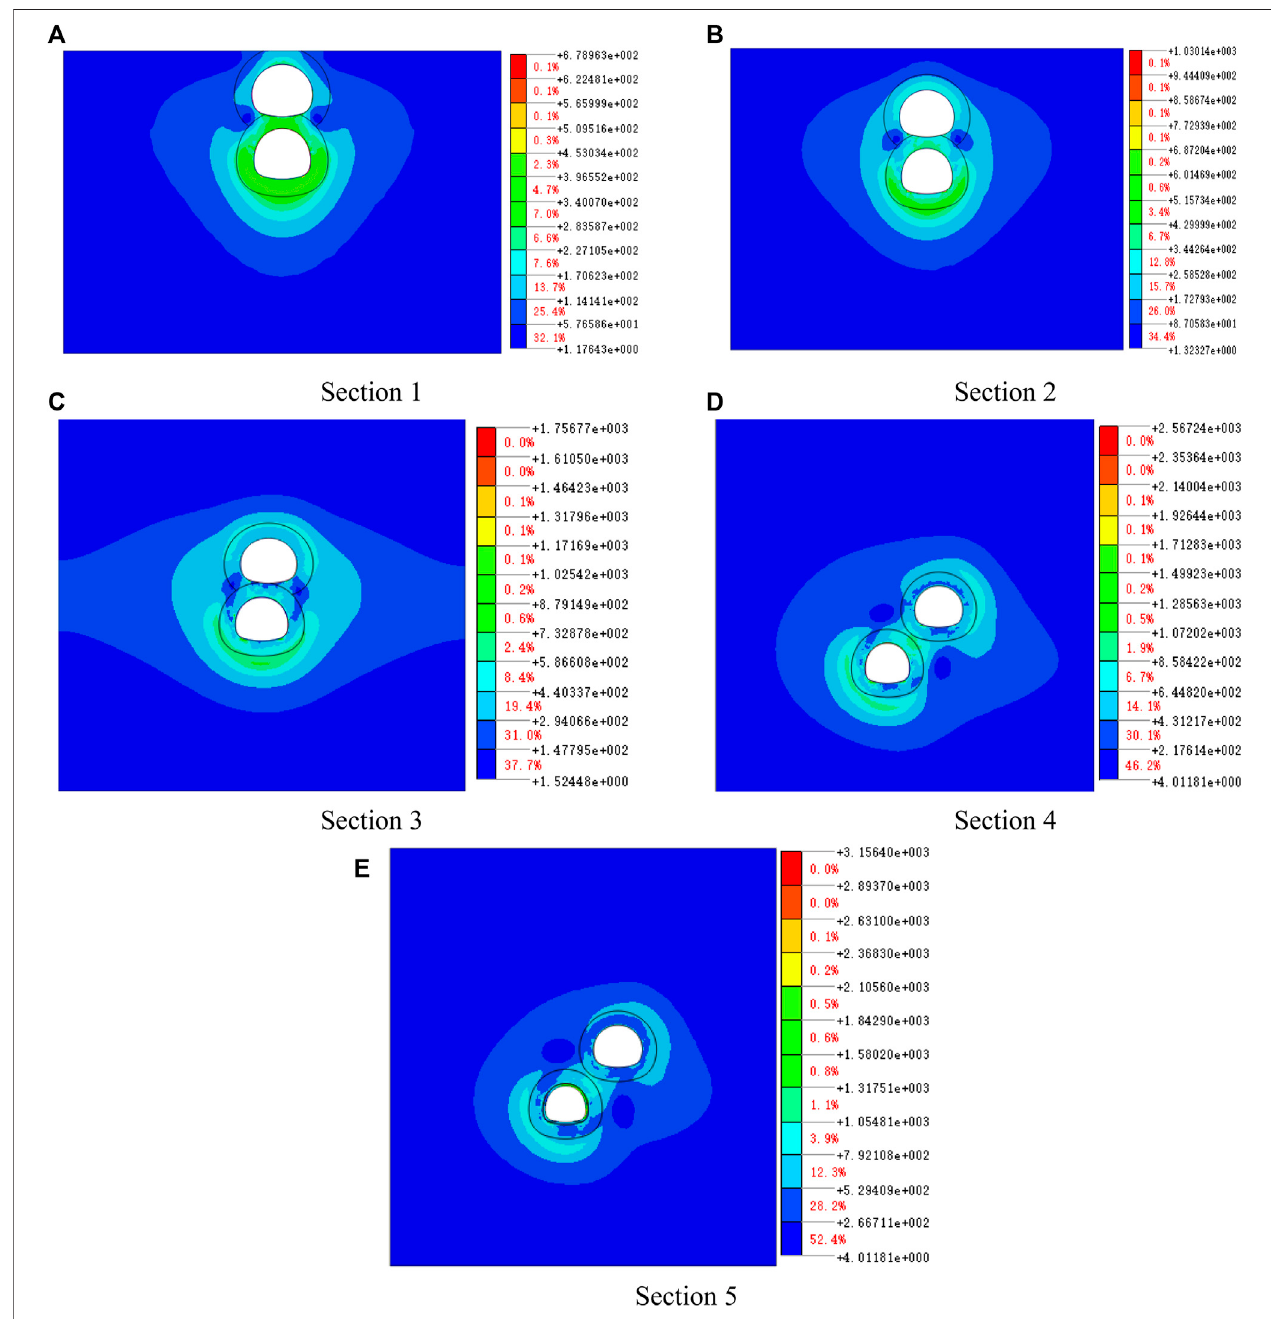
FIGURE 16 | Maximum shear stress cloud diagram of displacement at different cross-sections (unit: kPa).